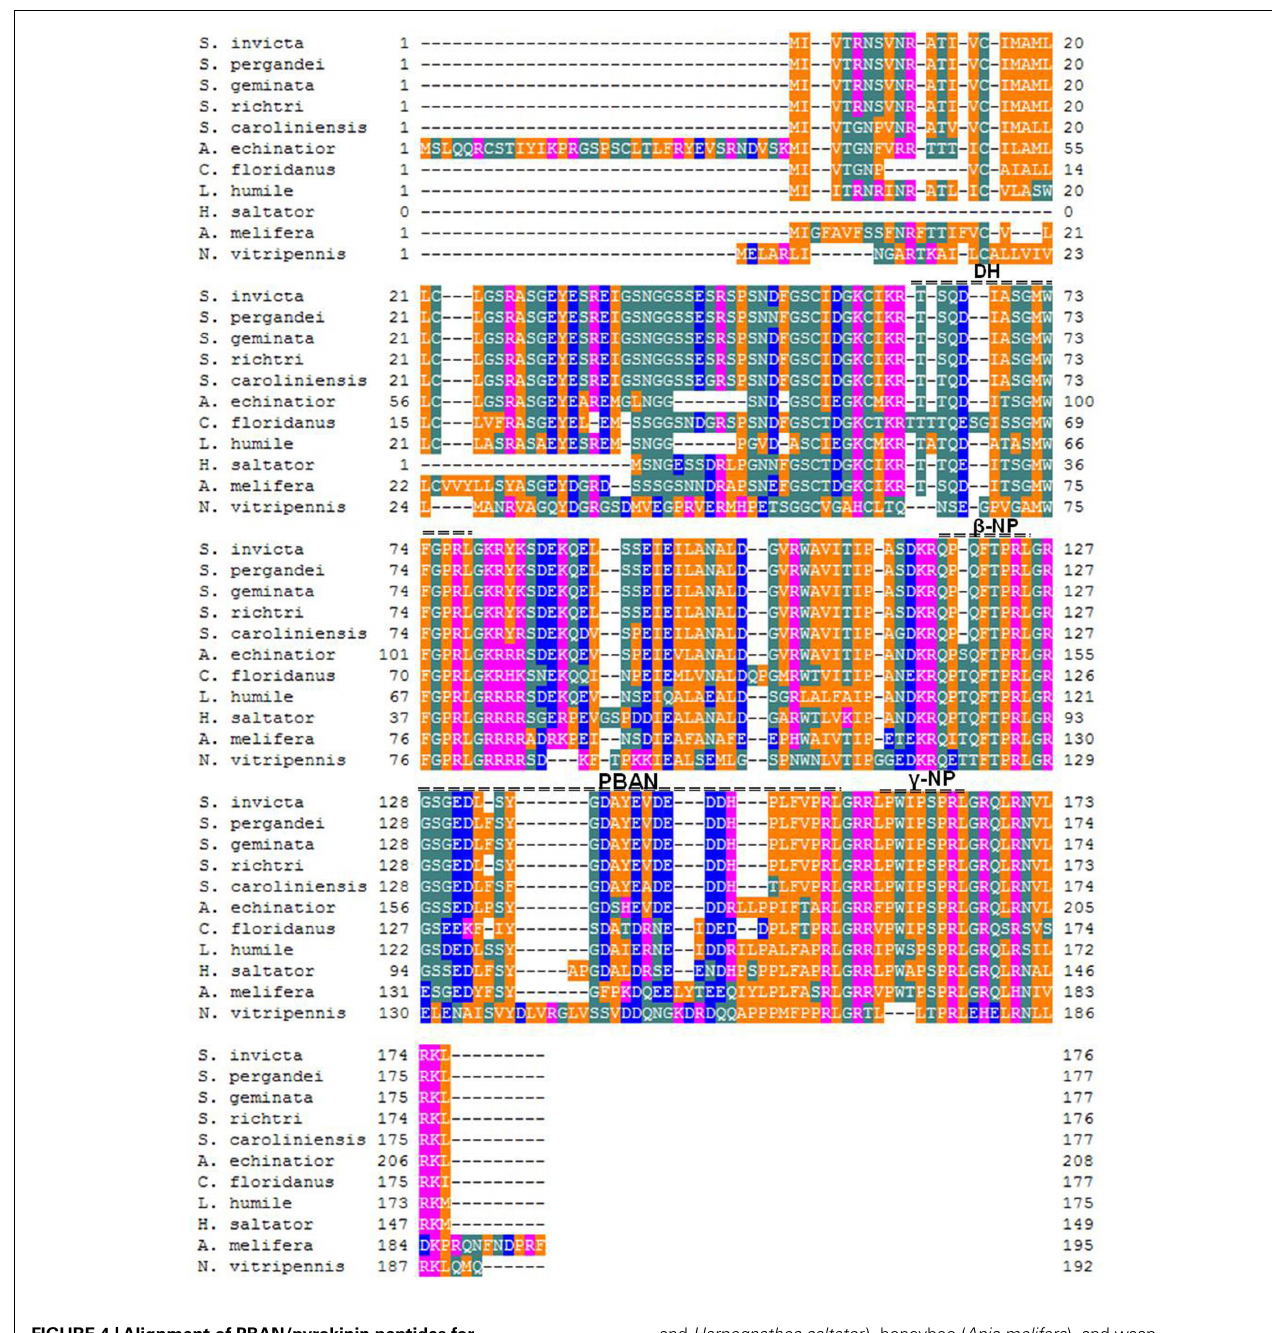
FIGURE 4 |Alignment of PBAN/pyrokinin peptides for hymenopteran insects. The species names are follow: ants ( Solenopsis invicta , S. pergandei , S. geminate , S. richteri , S. carolinensis , Acromyrmex echinatior , Camponotus floridanus , Linepithema humile